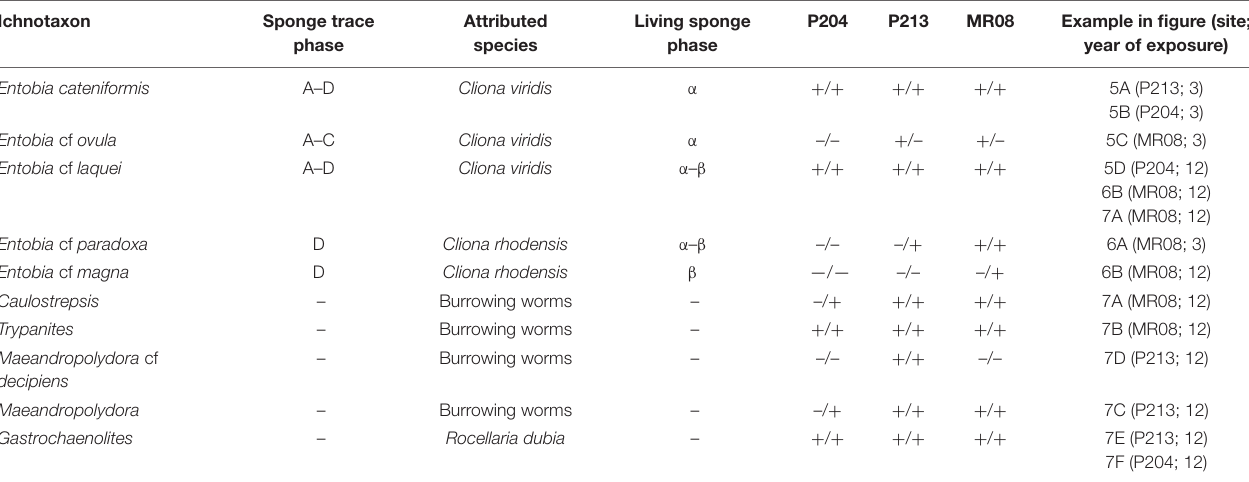
TABLE 4 | Ichnotaxa identified in the experimental tiles with the corresponding living